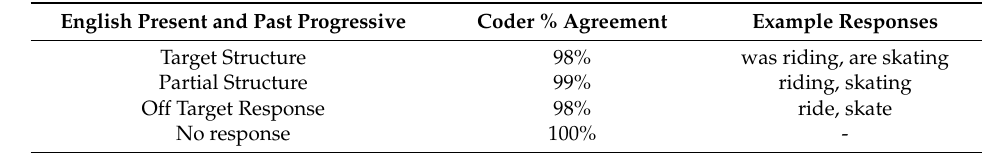
Table 3. Sample of Coded Responses—English Present Progressive.